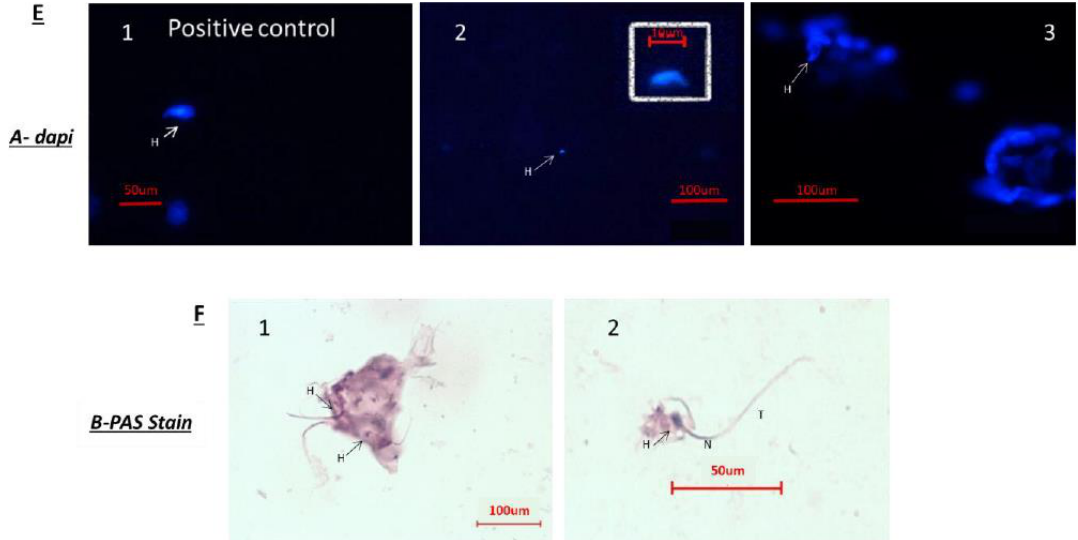
Figure 6. Development of spermatogenesis in vitro from BU-treated immature mice: Ten days after BU injection (see Figure 1), the testes were removed, seminiferous tubules were separated, and cells were enzymatically isolated and cultured in a methylcellulose culture system (MCS). The MCS was composed of 42% methylcellulose, KSR (10%), StemPro, and growth factors (GDNF (glial cell line derived nerve growth factor), LIF (leukemia inhibitory factor), FGF (fibroblast growth factor), and EGF (epidermal growth factor)) (see Methodology). In some wells, we also added TNF- α (20 pg/mL), FSH (7.5 IU/mL), or testicular homogenates from immature mice (60 µ g/mL) or testicular homogenates from GFP-adult mice (60 µ g/mL). Every 10–14 days, we added new media containing the same composition of factors that was added in the beginning of the culture. After 4–6 weeks, the developed colonies and cells ( A ) were collected, and the cells were fixed using cold methanol and were stained using immunofluorescence staining, using specific antibodies for markers of the premeiotic (CD9 and VASA), meiotic (CREM, BOULE, and ACROSIN), and postmeiotic (ACROSIN) cells. The effect of FSH and TNF-alpha ( B ) testicular homogenates from immature ( C ) or adult ( D ) mice on the development of spermatogenic cells in vitro compared to before the culture or the control (CT; after culture in the presence of growth factors) were examined. In addition, the development of the sperm-like cells in the cultures was examined according to the DAPI staining of sperm head morphology [ E ; E1—positive control of a sperm head (H); E2—a single sperm head developed in the culture; E3—a group of sperm heads developed in the culture] or periodic acid–Schiff (PAS) staining [ F ; F1—a group of sperm-like cells with heads (H) and tails; F2—a few sperm-like cells with complete morphology of head